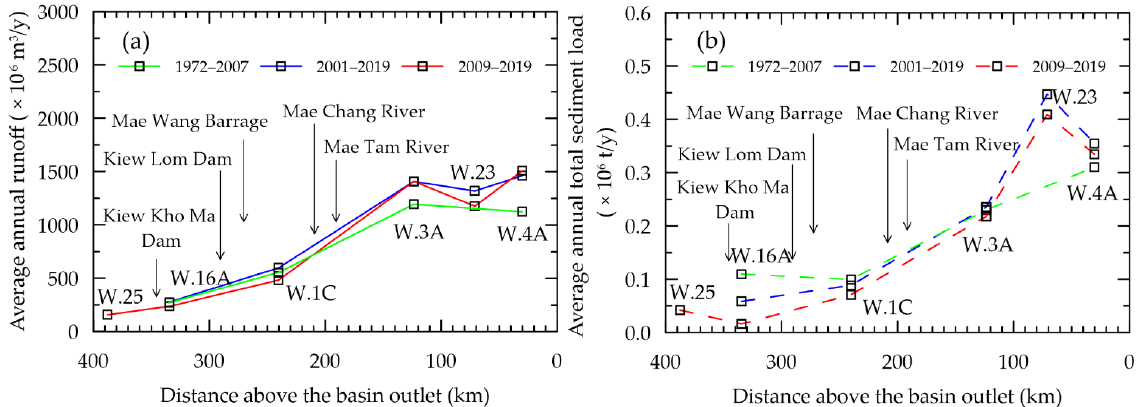
Figure 6. Plots of ( a ) average annual river runoff and ( b ) annual total sediment load along the Wang River. Water 2021 , 13 , 2146